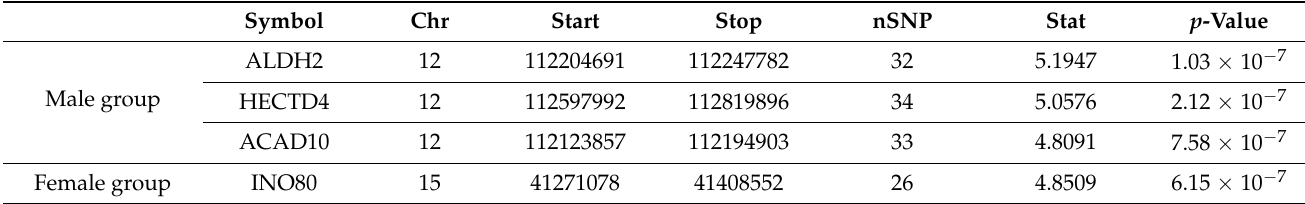
Table 4. Results of sex-stratified MAGMA analysis for systolic blood pressure.